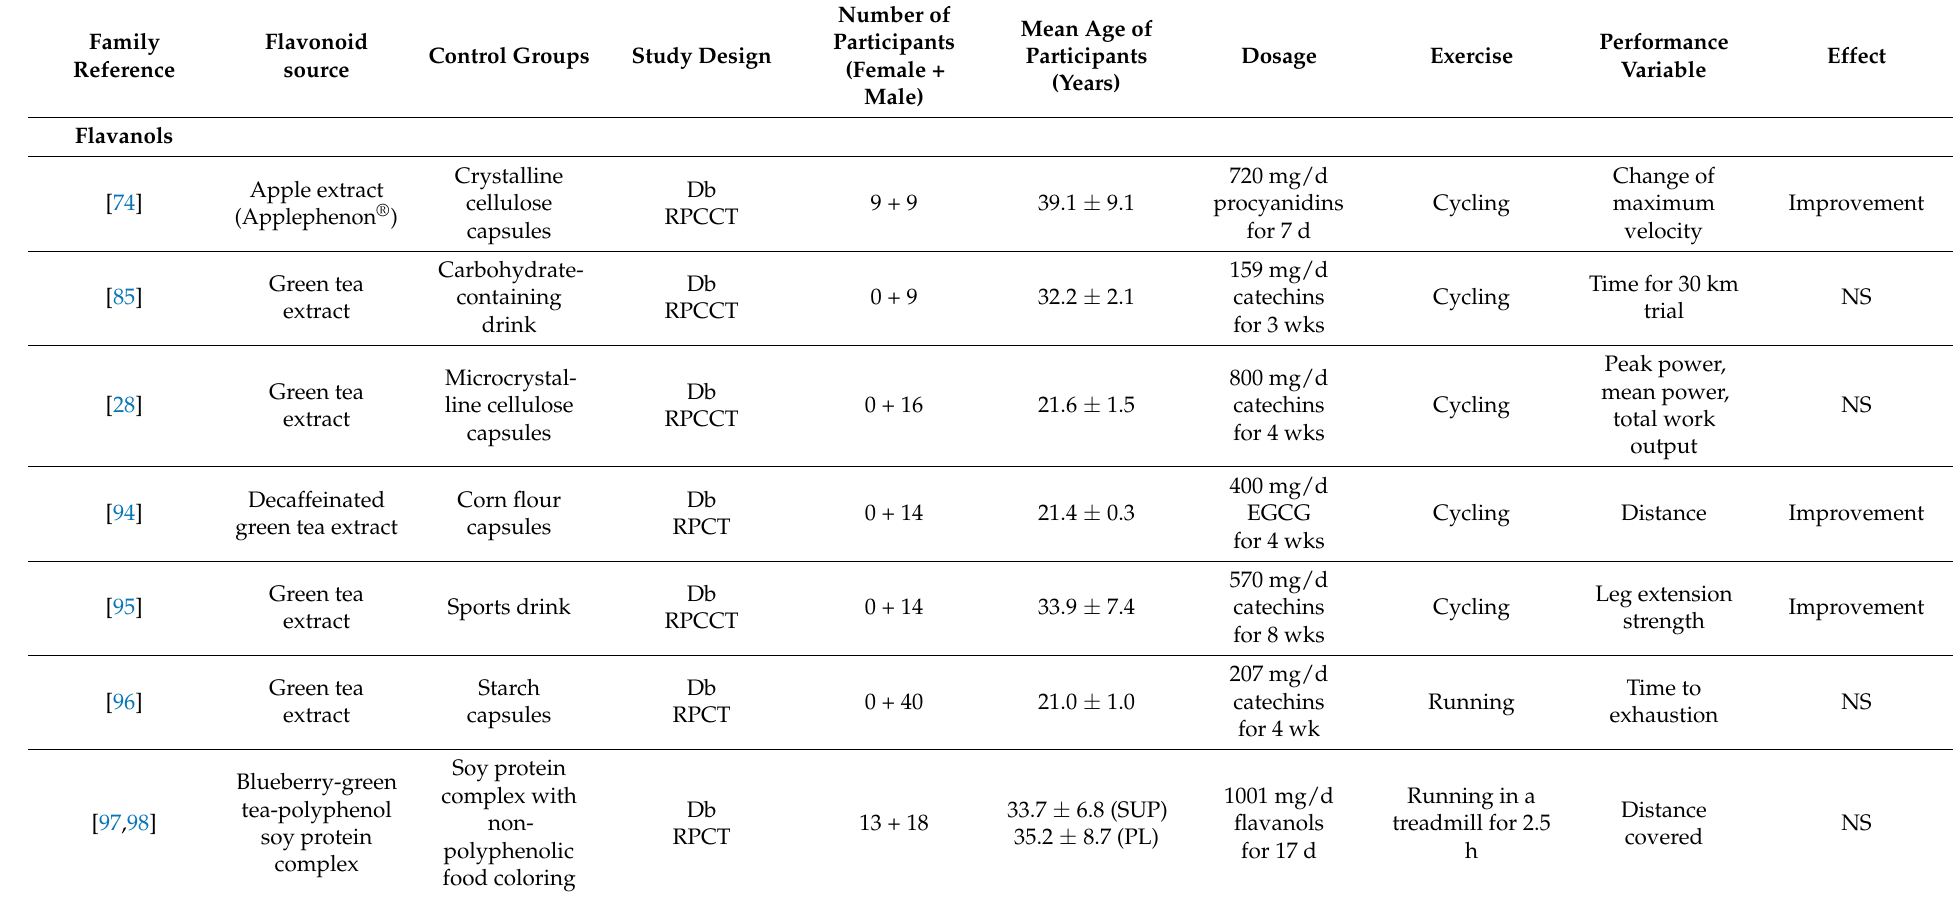
Table 2. Summary of the included studies assessing the effects of flavonoid-enriched extracts on exercise